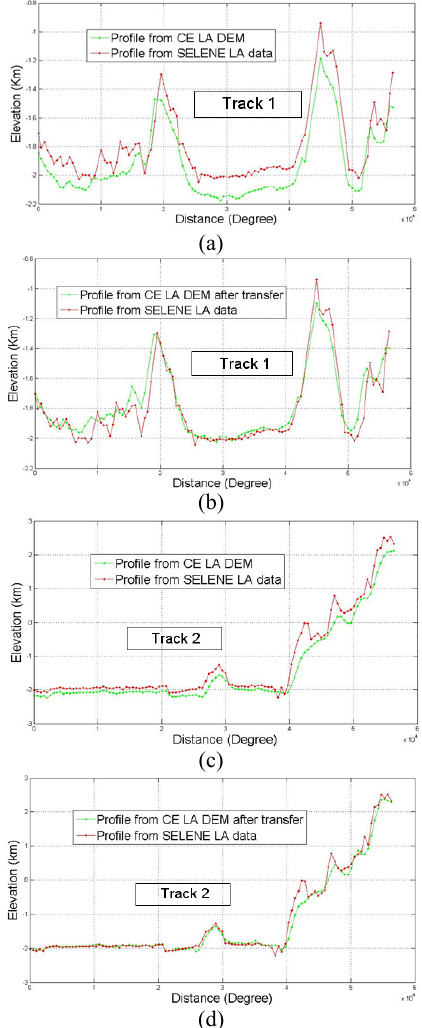
Figure 9. Profile comparison between the SELENE and Chang’E-1 data sets, (a) and (b) : the profiles from track 1 before and after transformation, respectively, (c) and (d) : the profiles from track 2 before and after transformation, respectively From Figure 9, it can be noticed that the general trend among these profiles are identical to the real terrain of the Moon. However, differences between them before and after the least squares matching can also be found. Statistical data including average, maximum, minimum and standard deviation values for each track and the whole area of 2D grey-scale images before and after the Least Squares Matching at the Apollo 15 Landing Site area are listed in Table 4 .